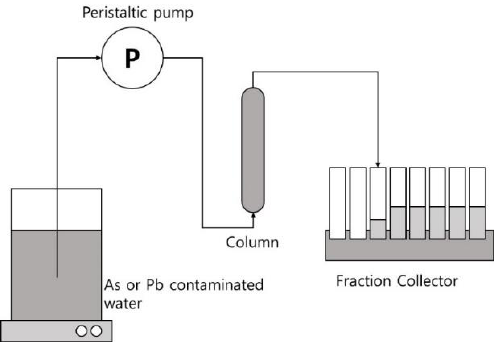
Figure 5. A schematic diagram of a column reactor system.